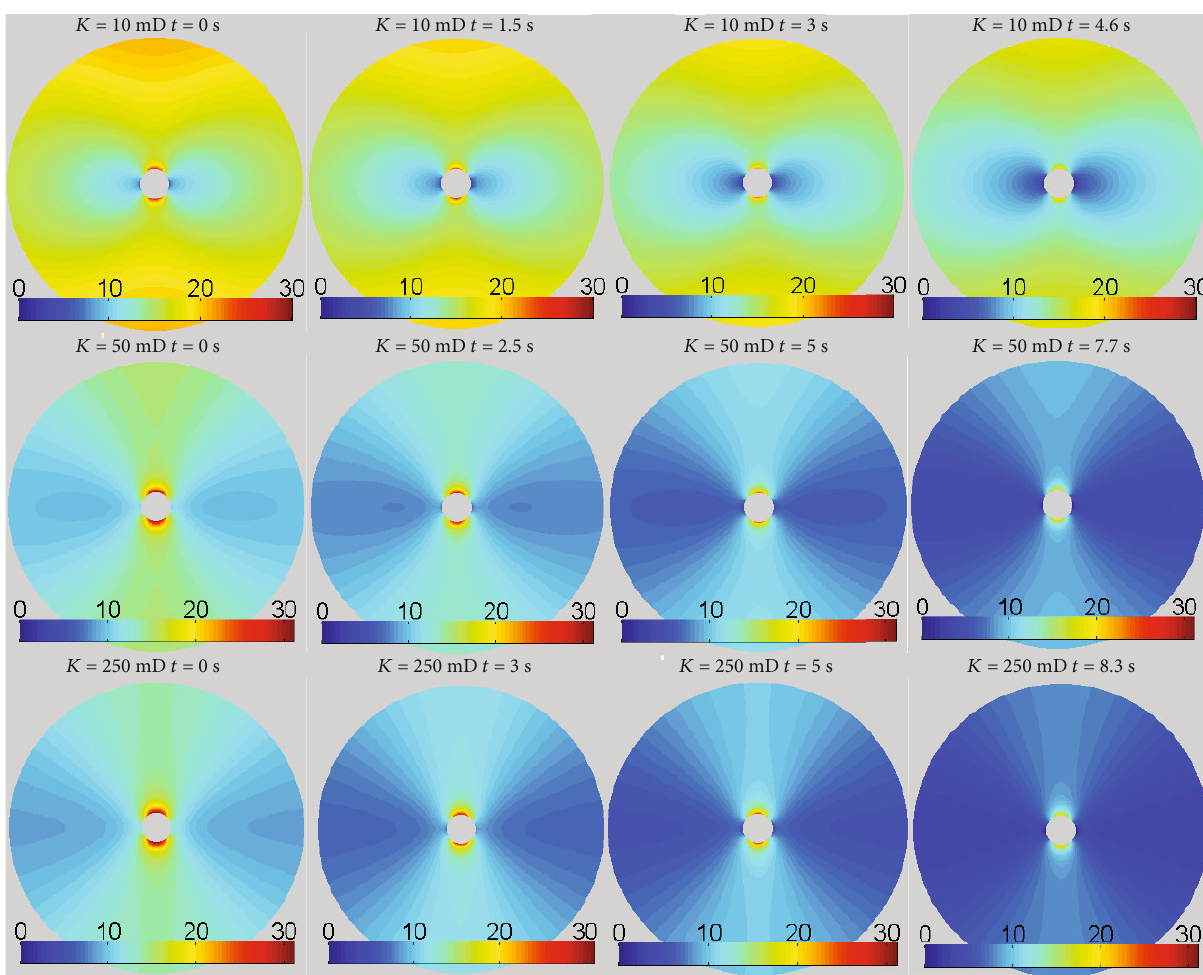
Figure 11: Formation breakdown process for three permeability rocks accounting seepage